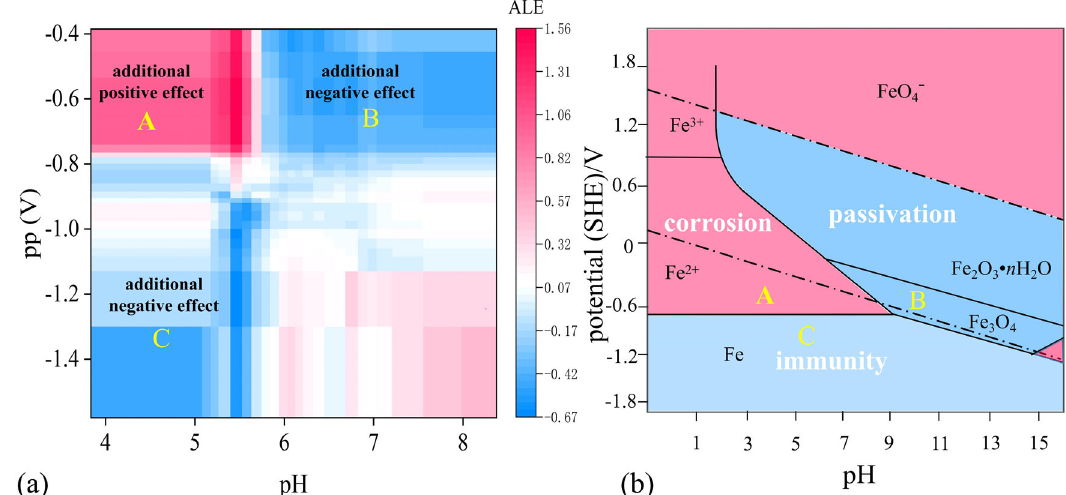
Fig. 10 Interaction of pH and pp. a ALE second-order interaction effect plot for pH and pp , b Pourbaix diagram of the Fe-H 2 O.